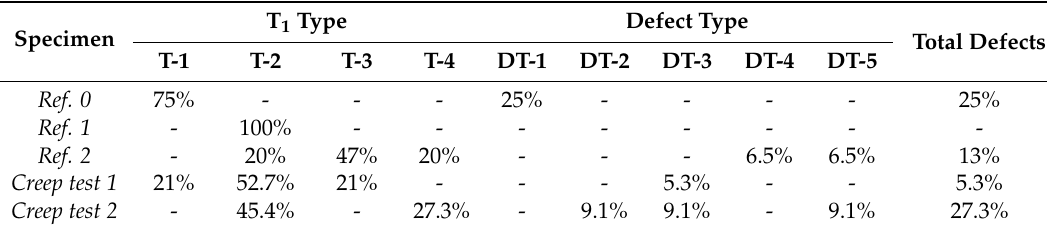
Table 3. Relative frequency of T 1 precipitate types after different aging treatments (see Figure 8 for details of the T 1 types and defect types).